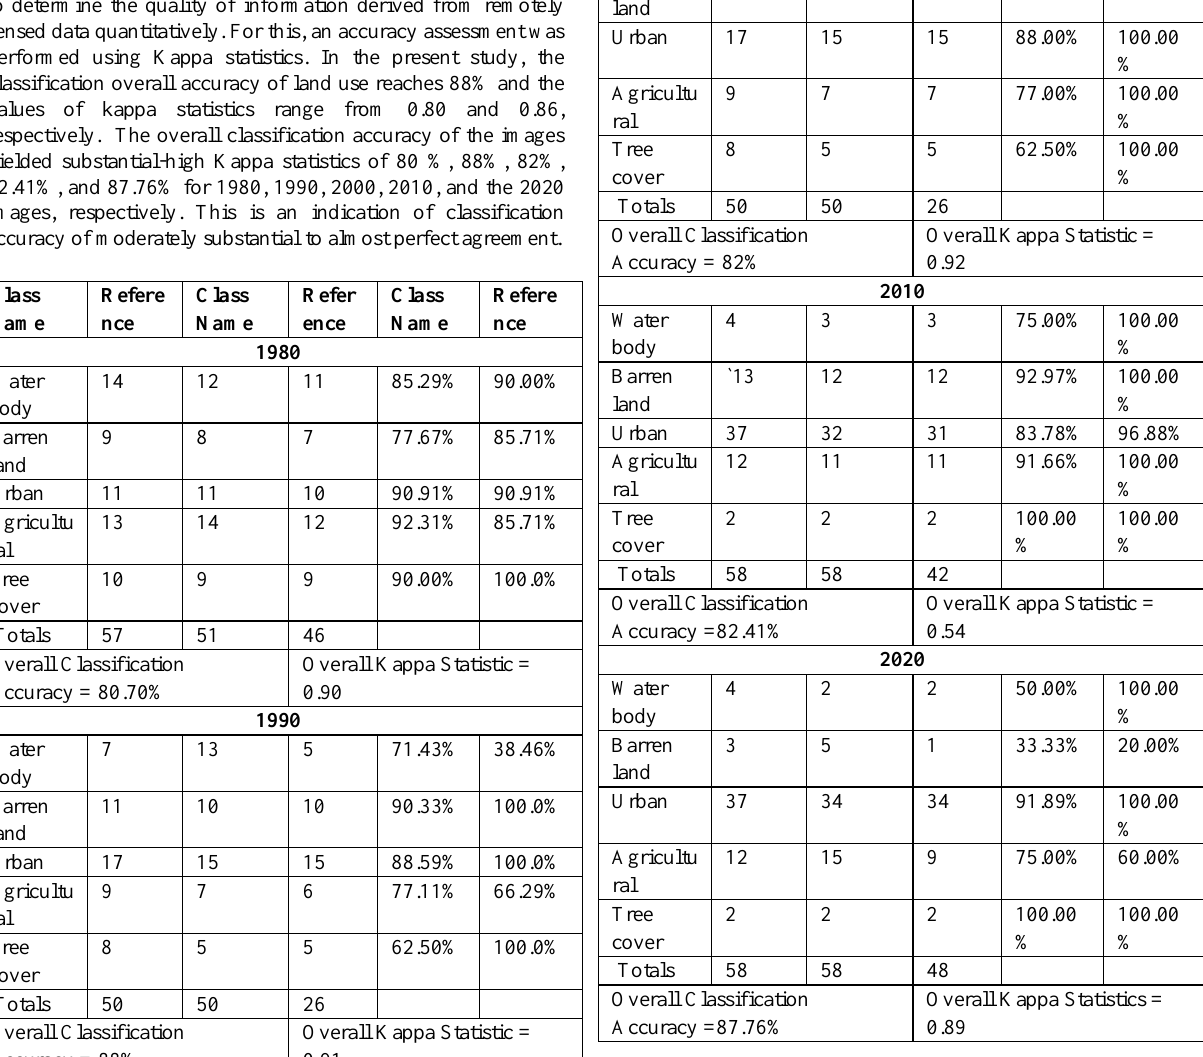
Table 3. Theoretical error matrix of LULC classification for